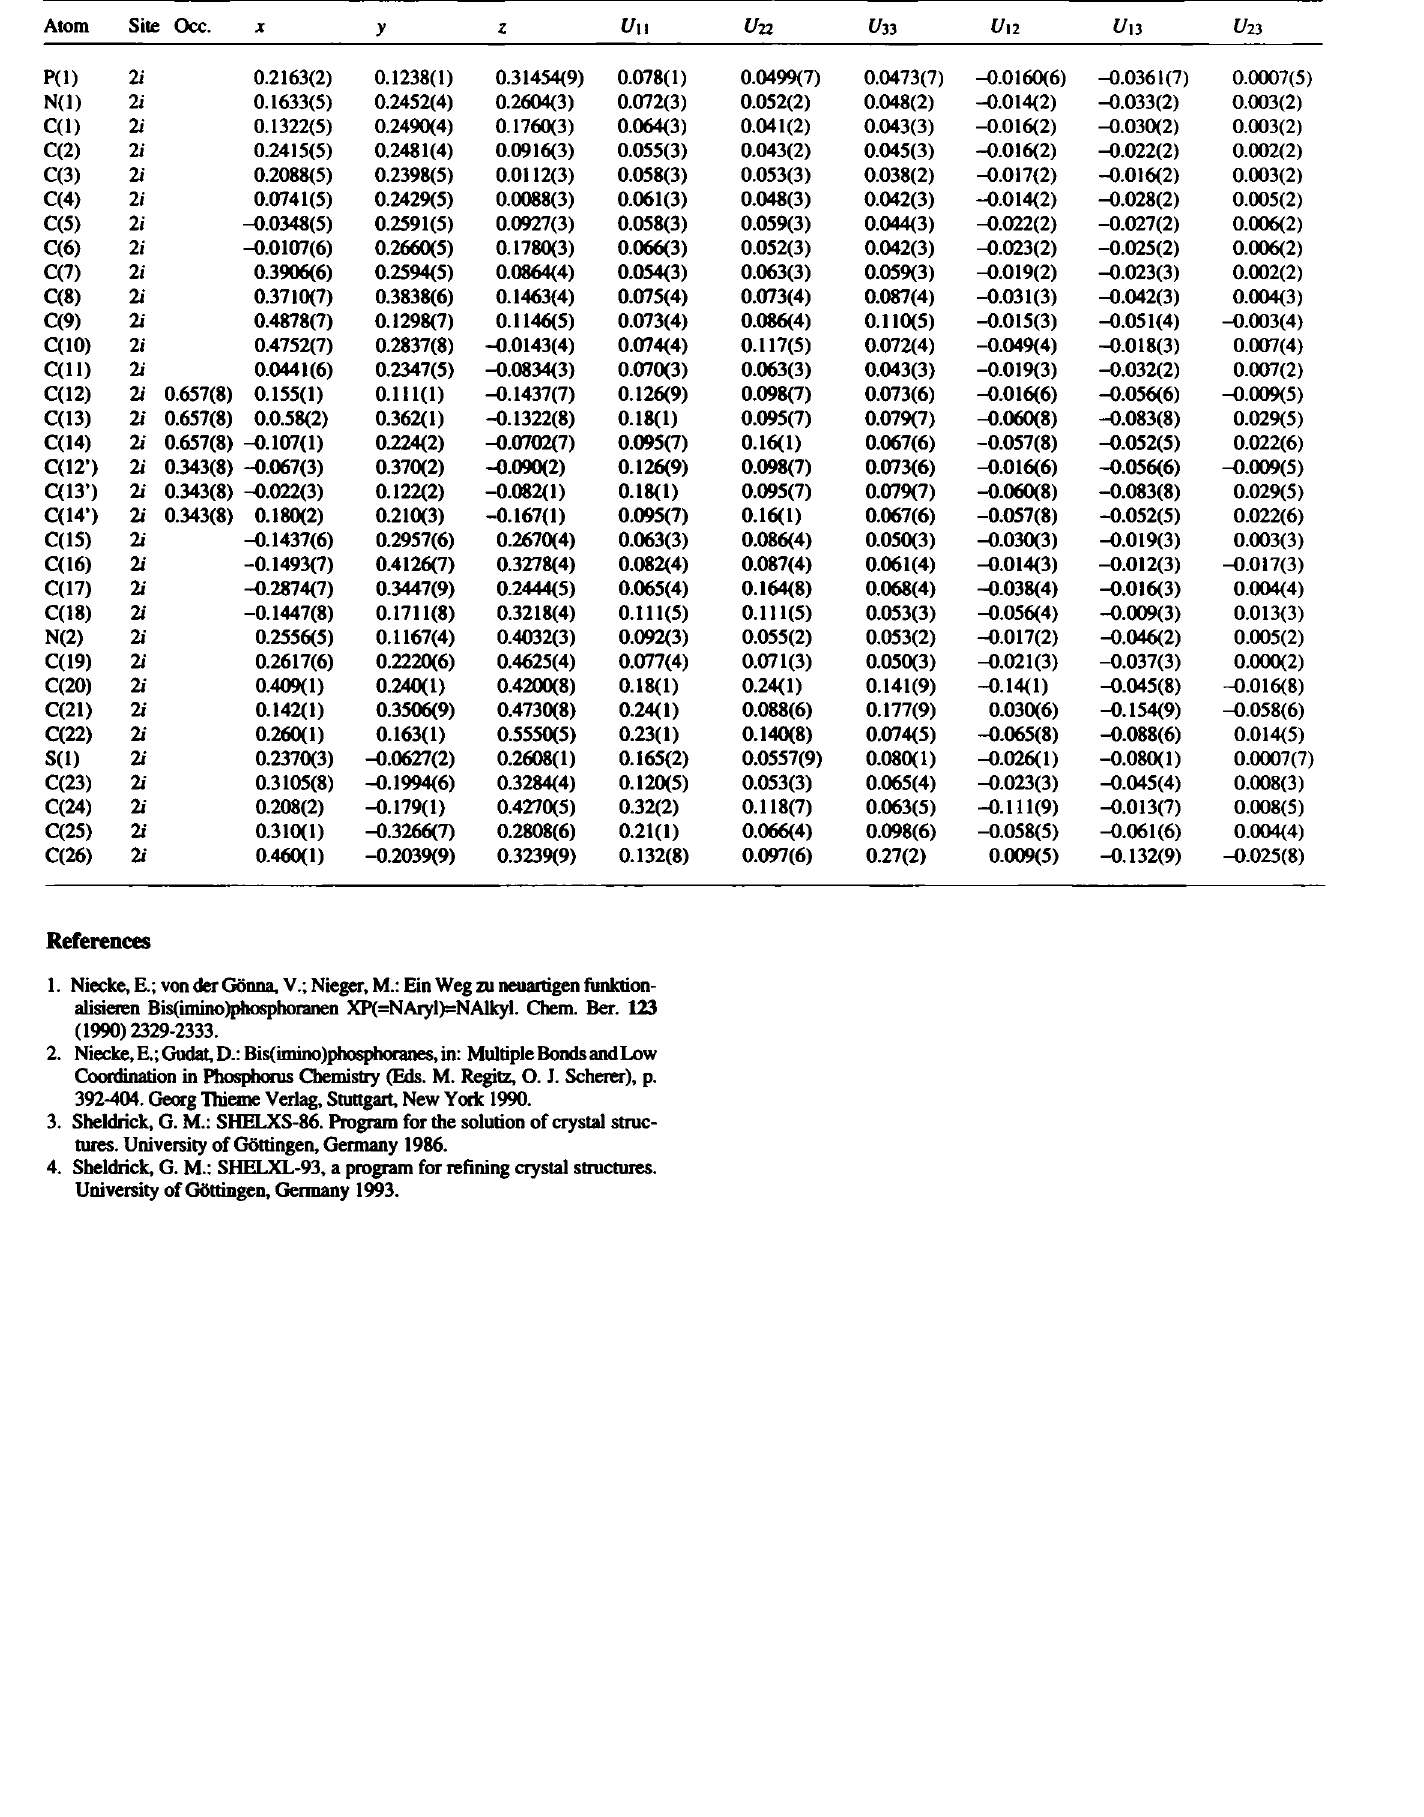
Table 3. Final atomic coordinates and displacement parameters (in A 2 ) Atom Site